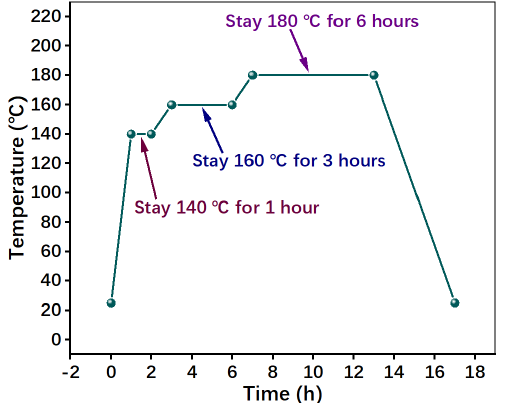
Figure 3. Heat-treatment of